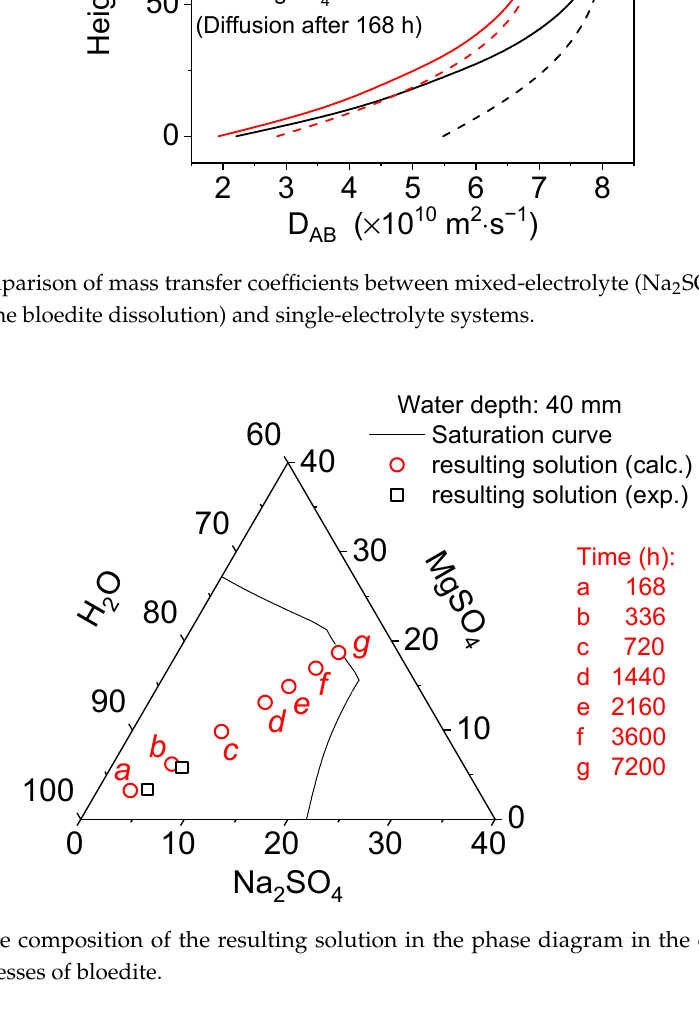
Figure 9. Comparison of mass transfer coefficients between mixed-electrolyte (Na 2 SO 4 -MgSO 4 -H 2 O system from the bloedite dissolution) and single-electrolyte systems.